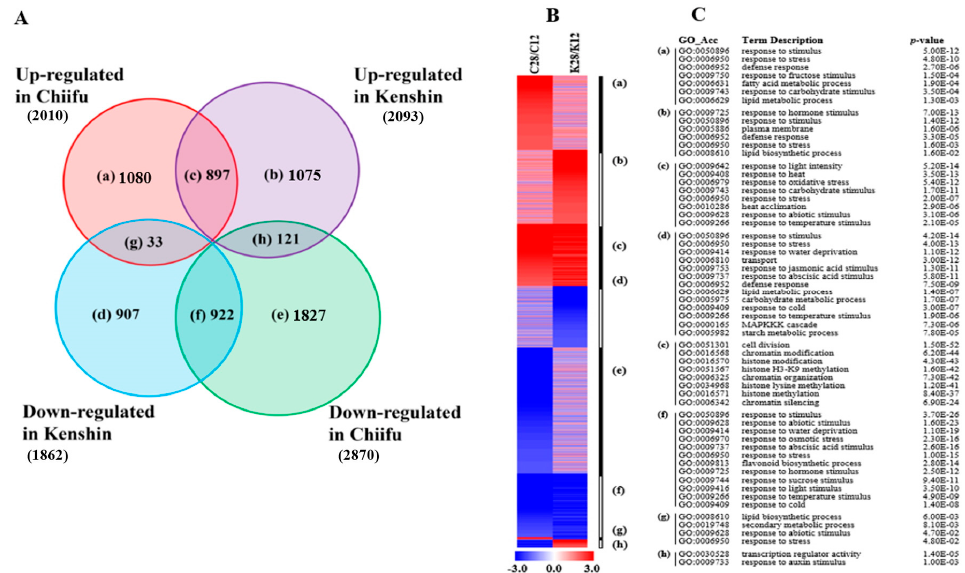
Figure 2. Analysis of warming-responsive genes from two contrasting inbred lines, Chiifu and Kenshin. ( A ) Venn diagram of DEGs with over 2-fold differences in expression; a–h indicate the groups of genes in each category; ( B ) Heatmap of DEGs in each group based on fold change; ( C ) Gene Ontology (GO) enrichment analysis of DEGs in each group, with p values obtained using the agriGO tool (http://bioinfo.cau.edu.cn/agriGO/index.php). C and K of Figure 2B indicate Chiifu and Kenshin, respectively. Int. J. Mol. Sci. 2018 , 19 , x FOR PEER REVIEW